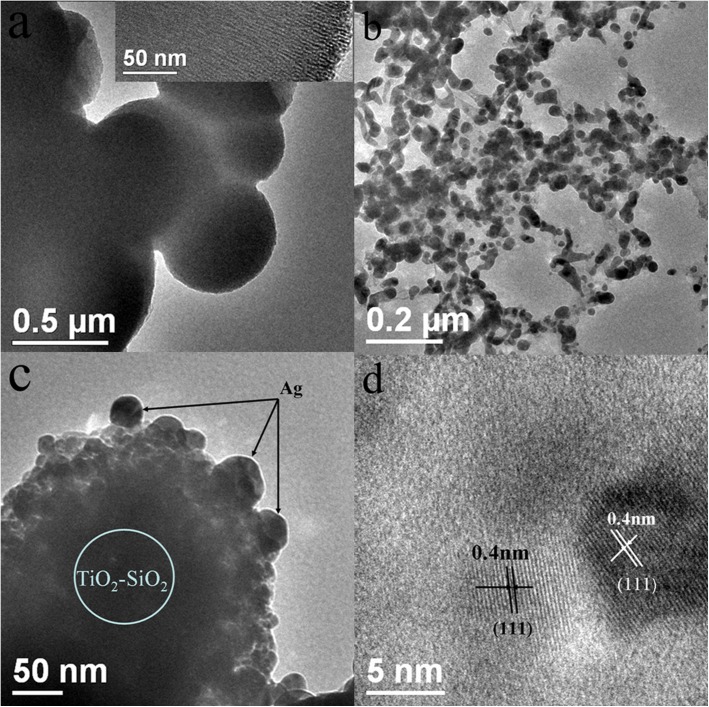
TEM images after calcination at 723 K of (a) TiO2-SiO2, (b) Ag (c) Ag-TS and (d)HRTEM image of Ag-TS.